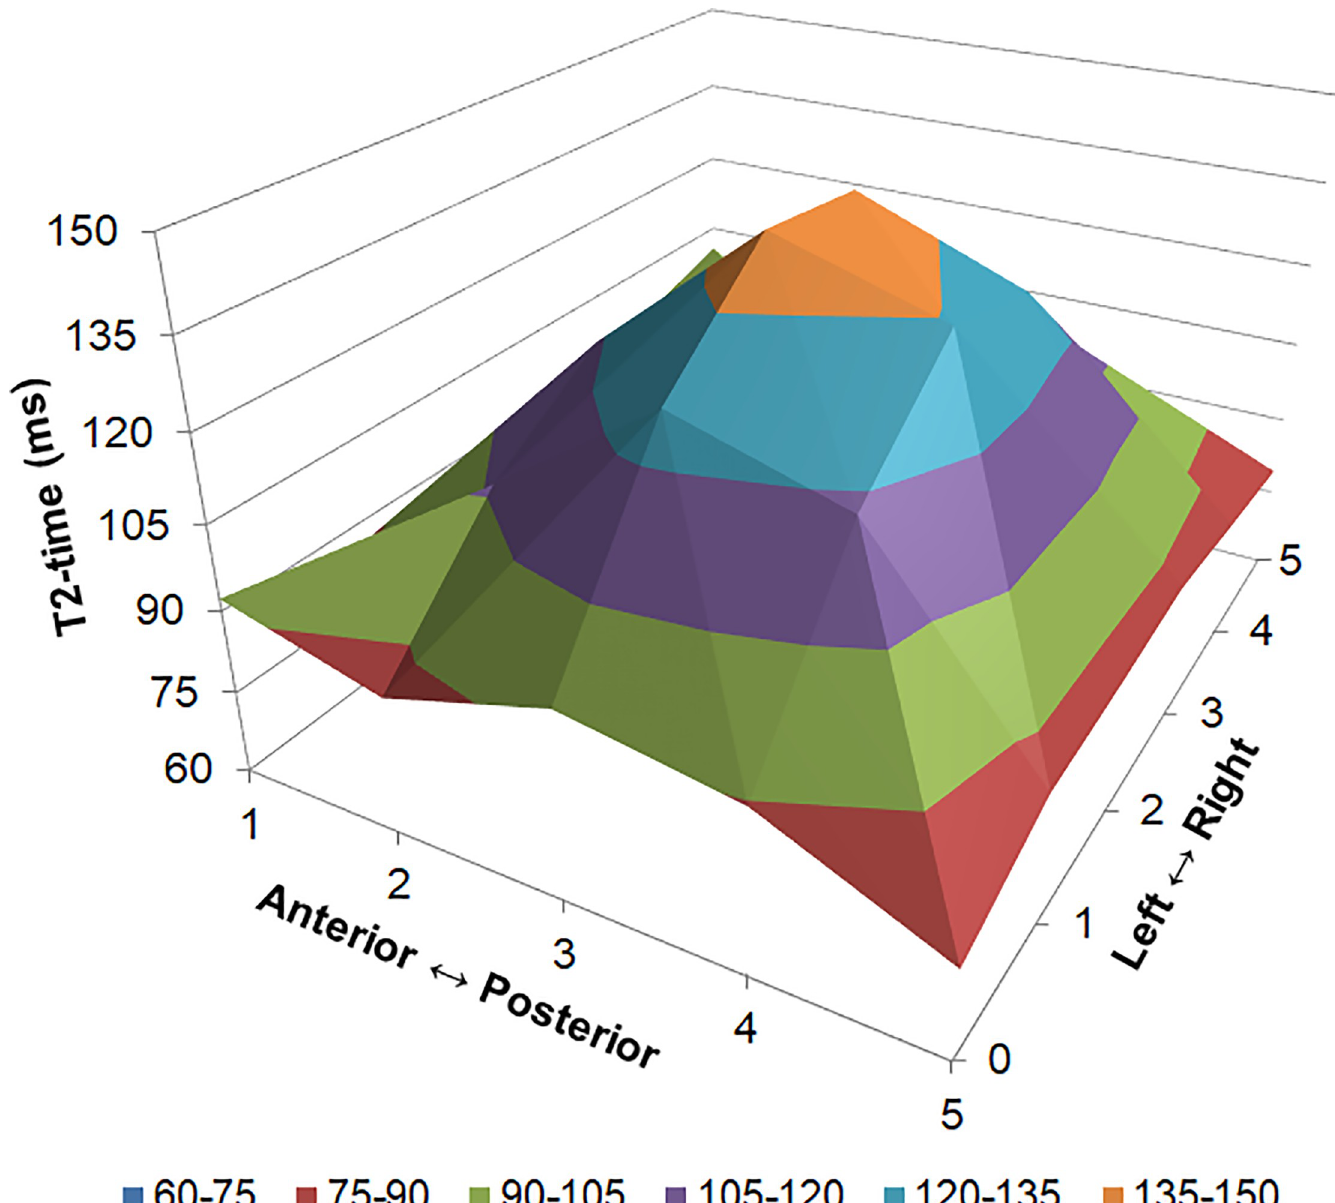
Fig 2. Three dimensional representation of T 2 distribution in the lumbar intervertebral disc. Data have been averaged from all intervertebral levels, scanning dates and participants. Values are mean T 2 (z-axis) in each of the five intervertebral disc subregions anterior to posterior (x-axis) and from on the six images from the left to right side of the spine